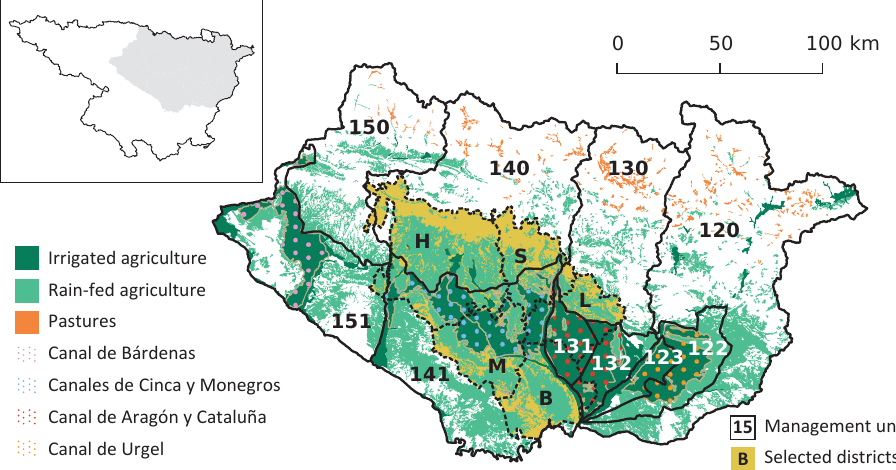
Figure 1. The north-eastern part of the Ebro Basin with selected agricultural land cover